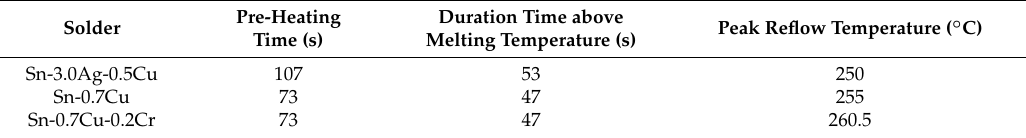
Figure 1. Reflow profile for SC-Cr/Cu solder joints. Table 1. Reflow